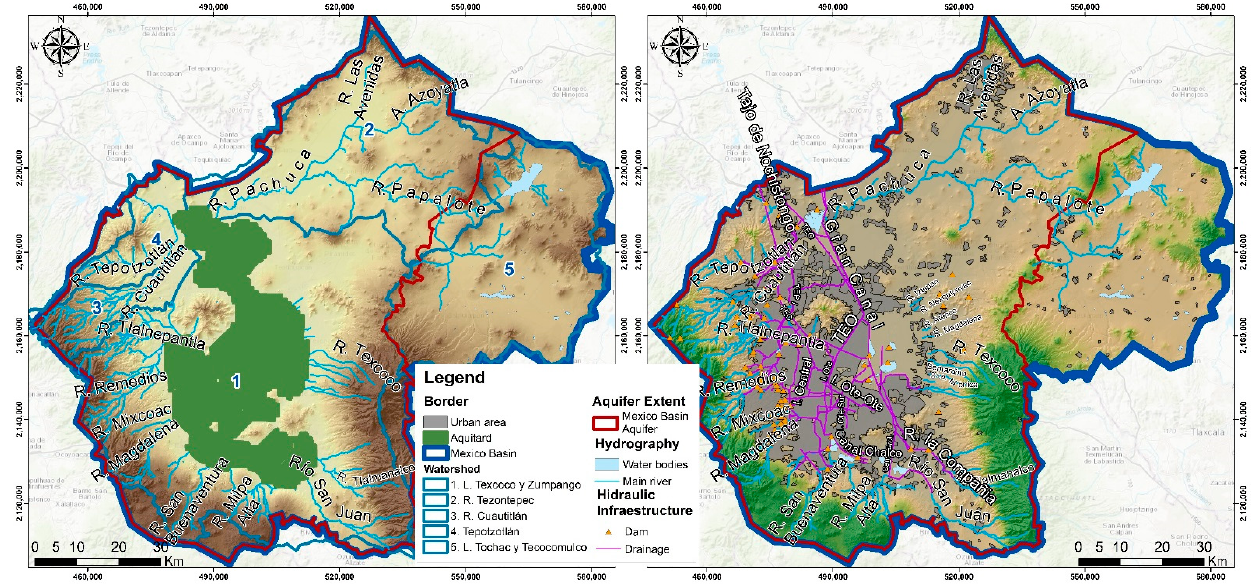
Figure 3. River watersheds, drainage and delimitation of the aquitard.